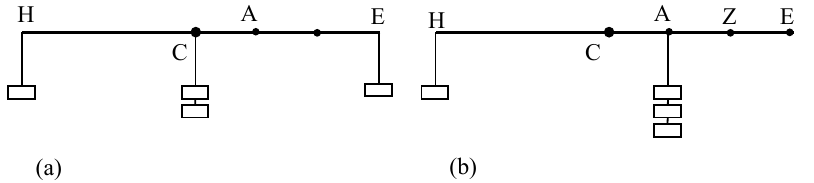
Figure 6. The law of the lever for a particular case: ( a ) first step of the proof; ( b ) second step of the proof; ( b ) is redrawn from [18], p.